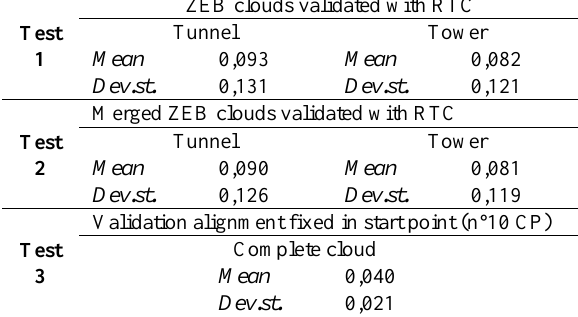
Table 5. 3-steps global evaluation